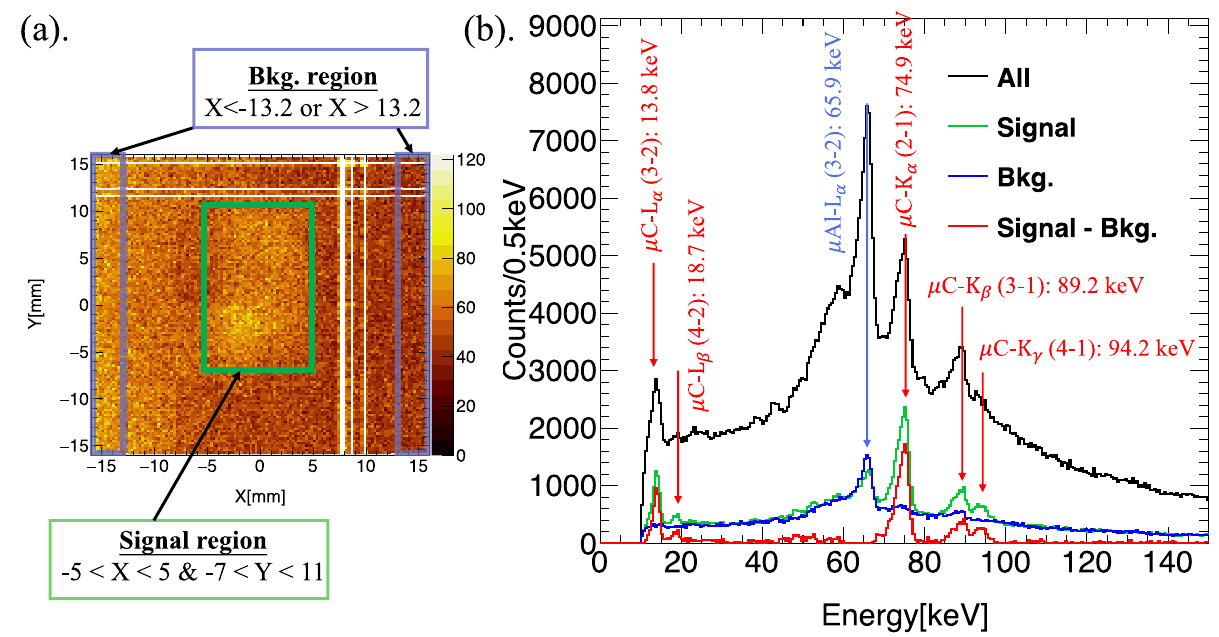
Figure 2. ( a ) Hit position of the incident photons with energy larger than 10 keV on the CdTe-DSD. The white bands in the image are the non-functioning strips. ( b ) Energy spectra of the signal and background muon beam axis every 30 min during the muon irradiation. This rotation enabled the CdTe-DSD to acquire projection images of the samples at various angles over the 0 ◦ – 360 ◦ range. The exposure to the muon beam with